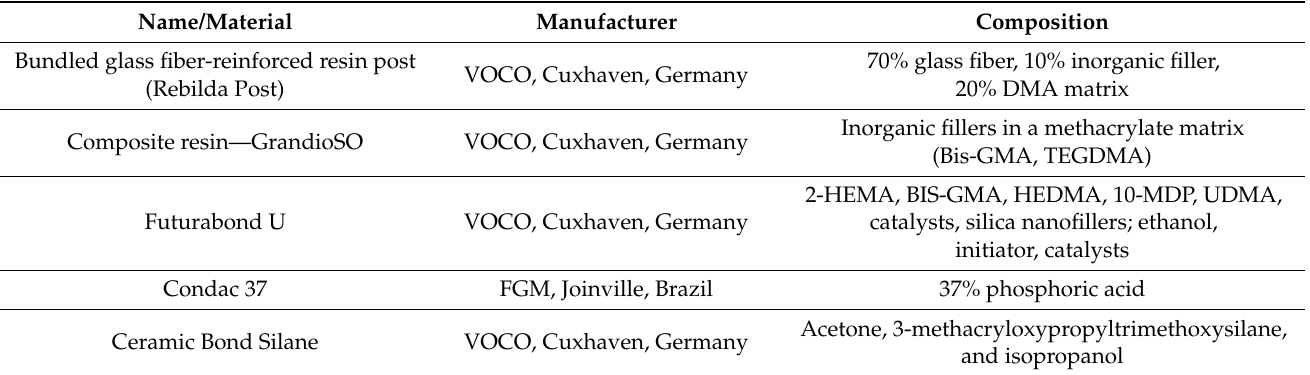
Table 1. Materials information used in the present